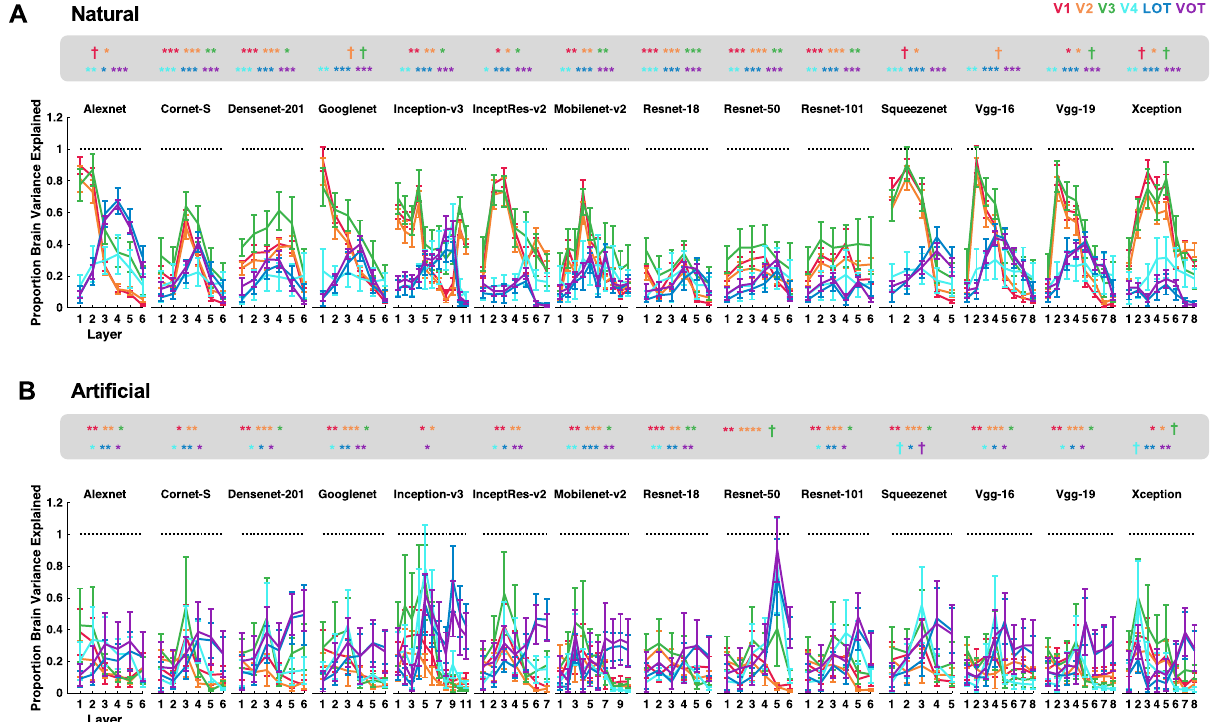
Fig. 6 Quantifying the proportion of explainable brain RDM variance captured by each sampled CNN layer in Experiment 3. A Results for real-world object images. B Results for arti fi cial object images. N = 6 human participants. The asterisks at the top of each plot mark the signi fi cance level of the difference between 1 and the highest proportion of variance explained by a CNN for each brain region; one-tailed t tests were used and all p values reported were corrected for multiple comparisons for the six brain regions included using the Benjamini – Hochberg procedure. Error bars indicate standard errors of the means. † p < 0.1, * p < 0.05, ** p < 0.01, *** p < 0.001. Source data are provided as a Source Data fi